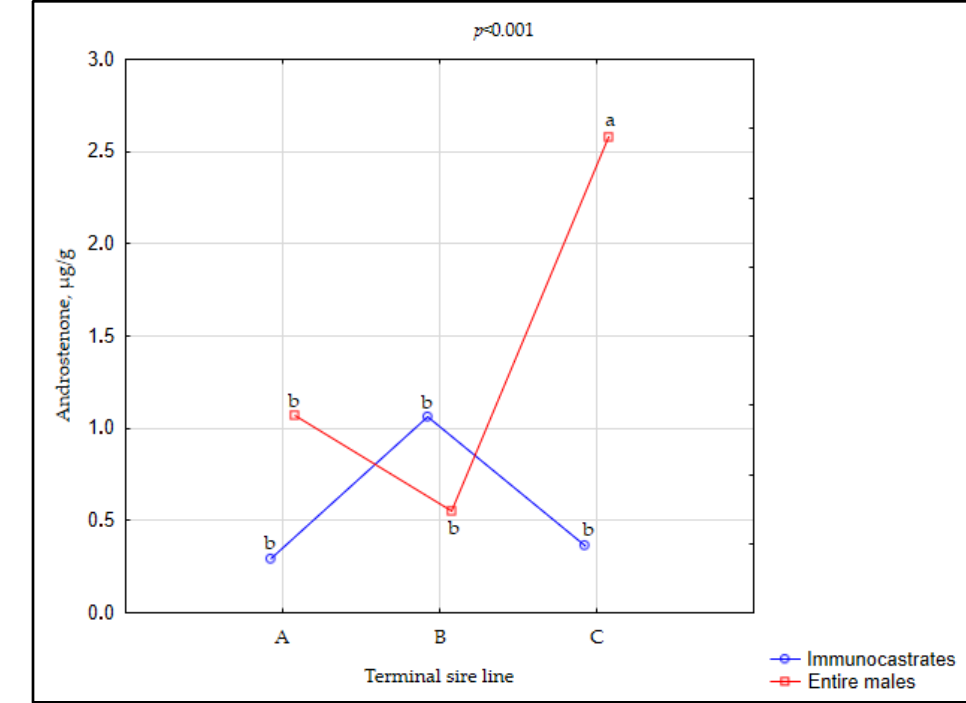
Figure 4. Interaction between terminal sire line and male category (MC) for androstenone concentration in immunocastrates (IC) and entire males (EM). TSL A = Pietrain × Large White, TSL B = pure Pietrain, TSL C= Pietrain × Duroc × Large White. Significant differences ( p < 0.05) between groups are denoted by different lowercase letters (a, b, c).